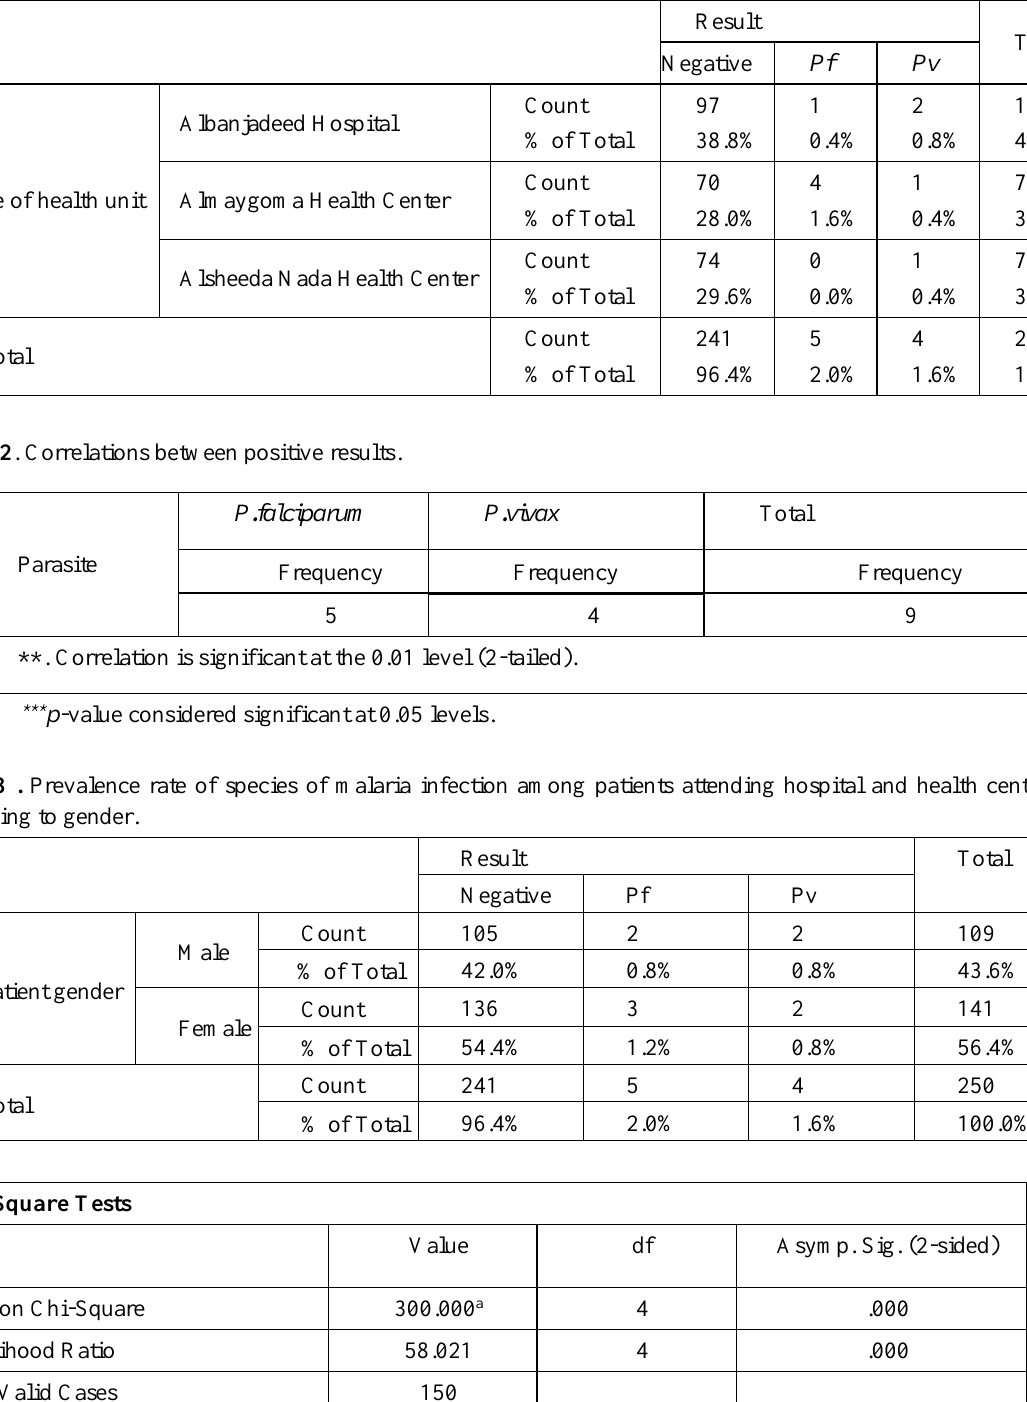
Table 1. The prevalence of malaria among patients according to centers.